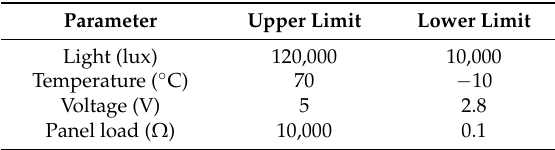
Table 2. Range of parameters used in the solar panel